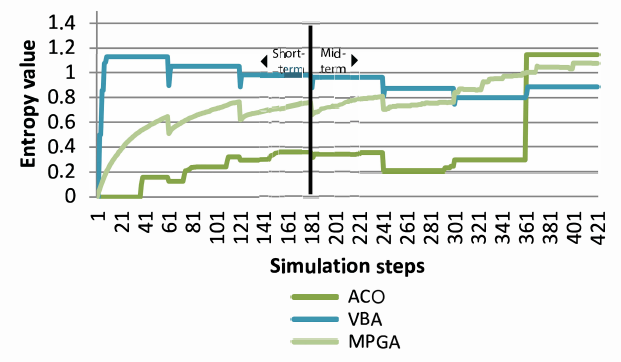
Figure 12. Algorithm comparison under mild (72%)